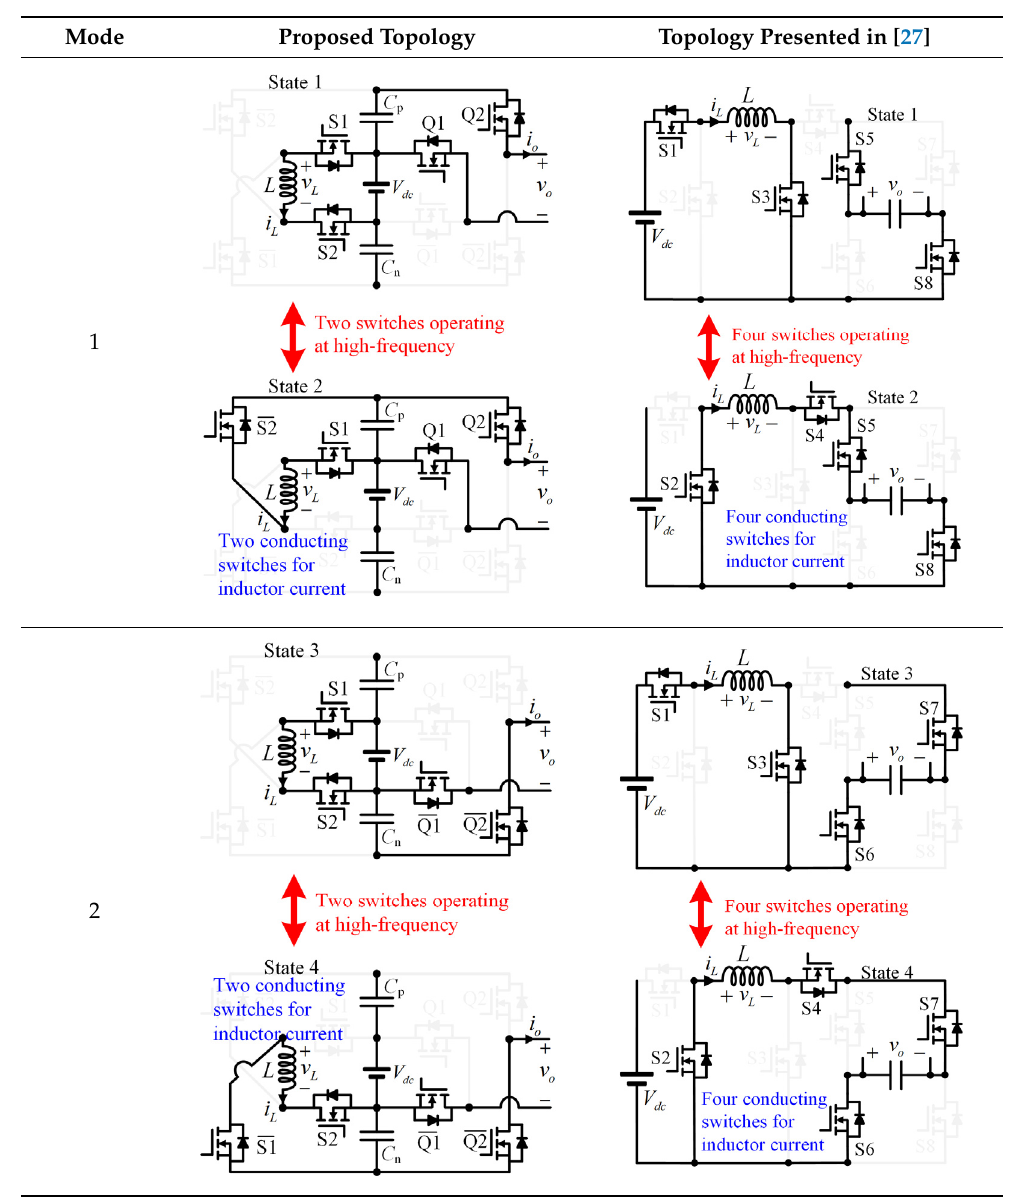
Table 1. Comparison between the proposed topology and the latest universal converter presented in [27].